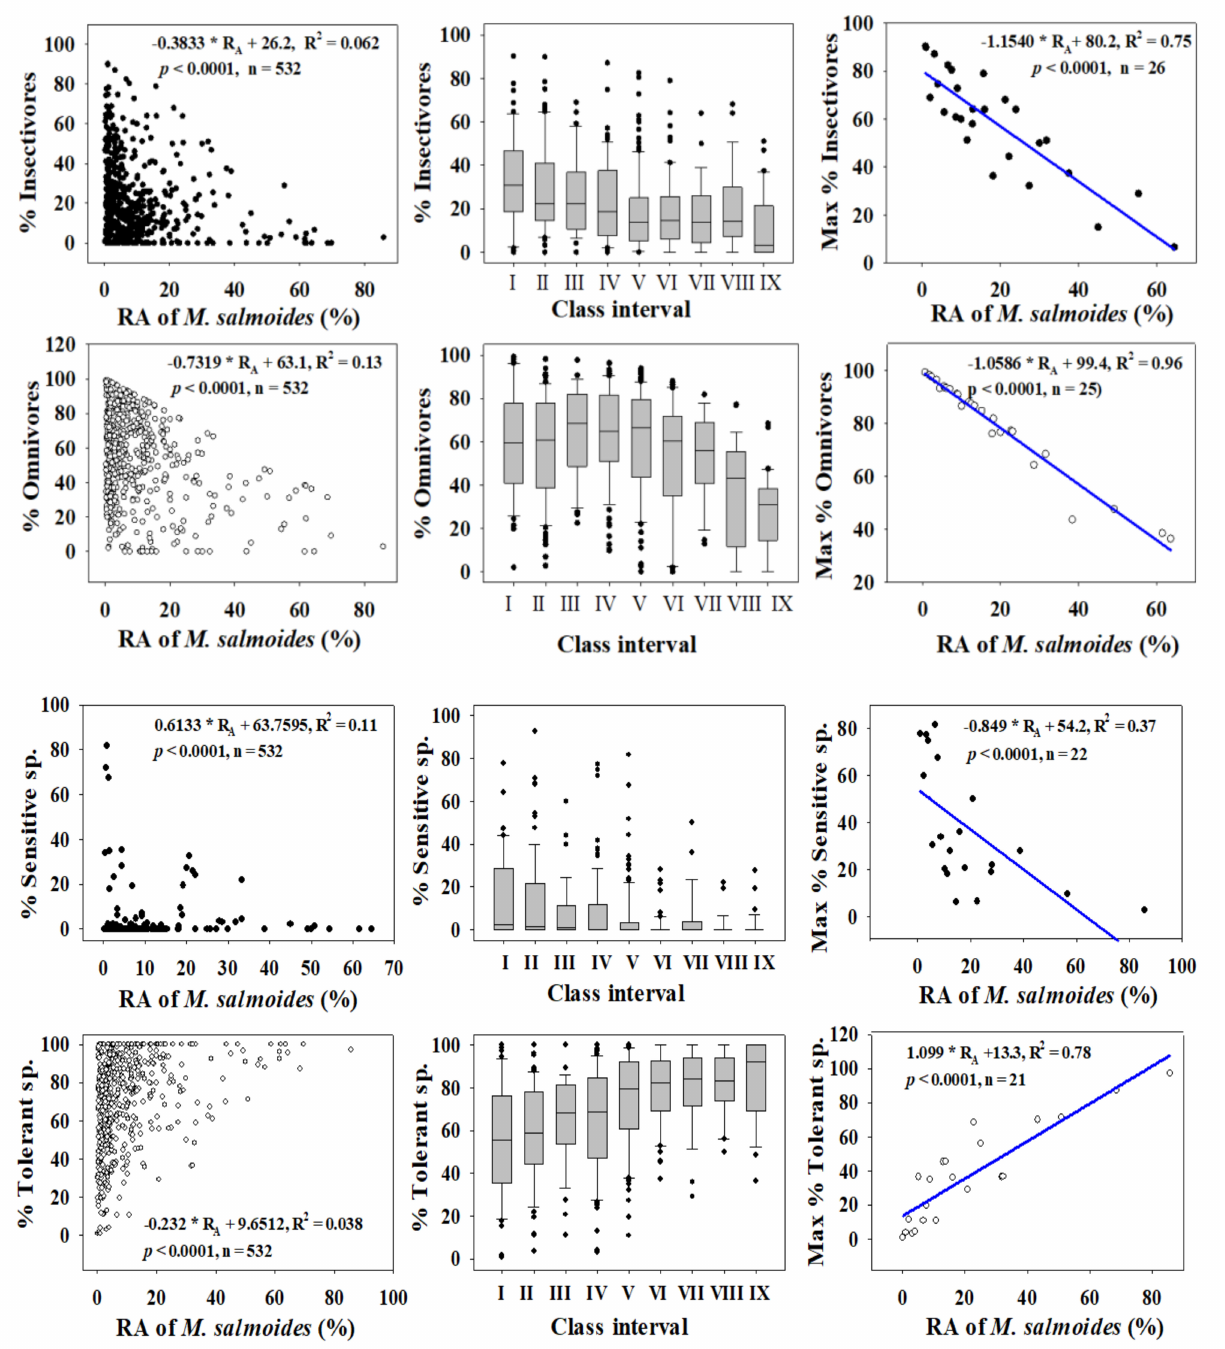
Figure 3. Dynamics of trophic and tolerance guilds in relation to the relative abundance (RA %) of Largemouth bass ( M. salmoides